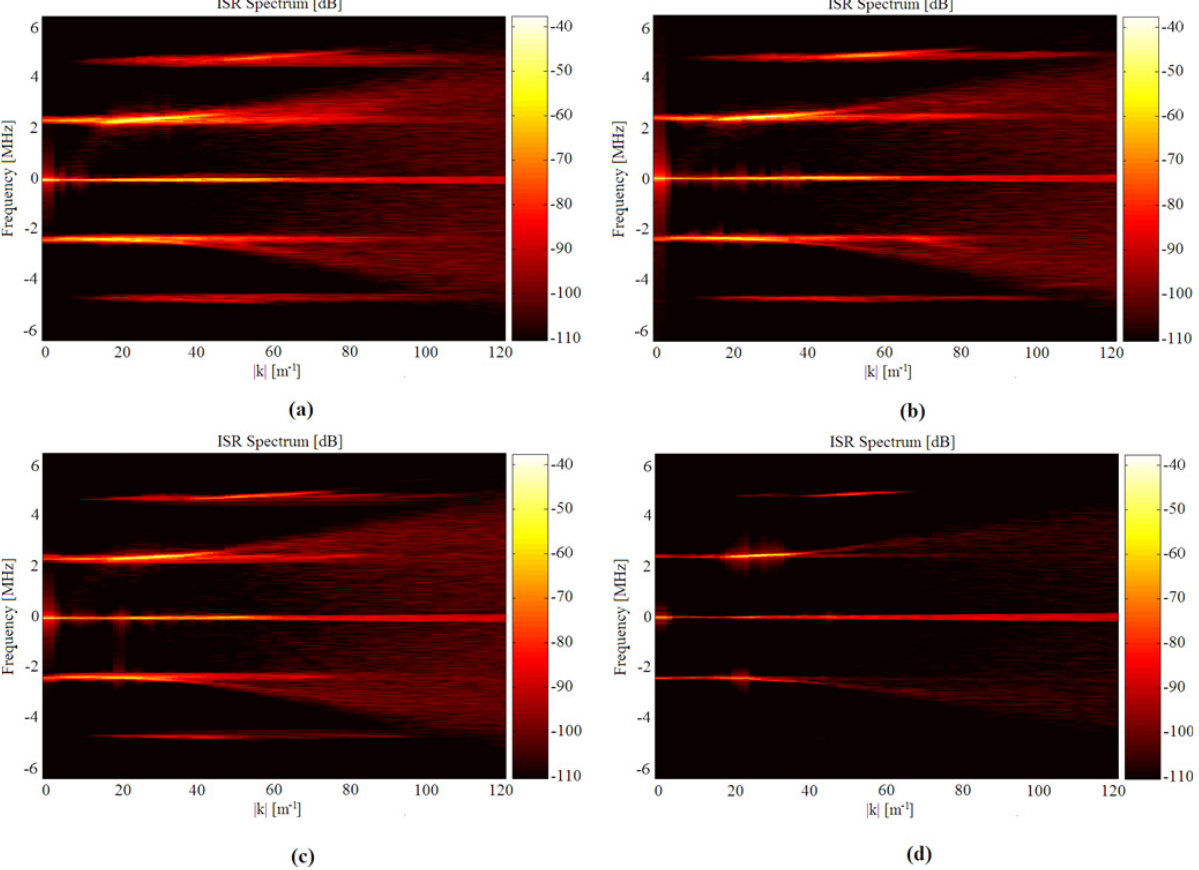
Fig. 5. Incoherent scatter spectrum for simulations with parameters presented in Sect. 3.1 for (a) n b = 1 × 10 9 m − 3 , (b) n b = 7 . 5 × 10 8 m − 3 , (c) n b = 5 × 10 8 m − 3 and (d) n b = 2 . 5 × 10 8 m − 3 . Table 3. Summary of theoretical wavenumbers of the cascaded waves for the case where n b = 7 . 5 × 10 8 and v b = 7 . 8 × 10 5 ms − 1